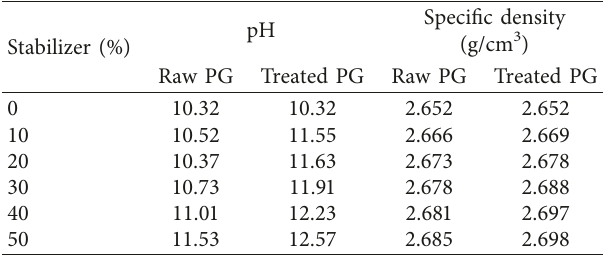
Table 4: pH and specific density of expansive soil (raw PG and treated PG).